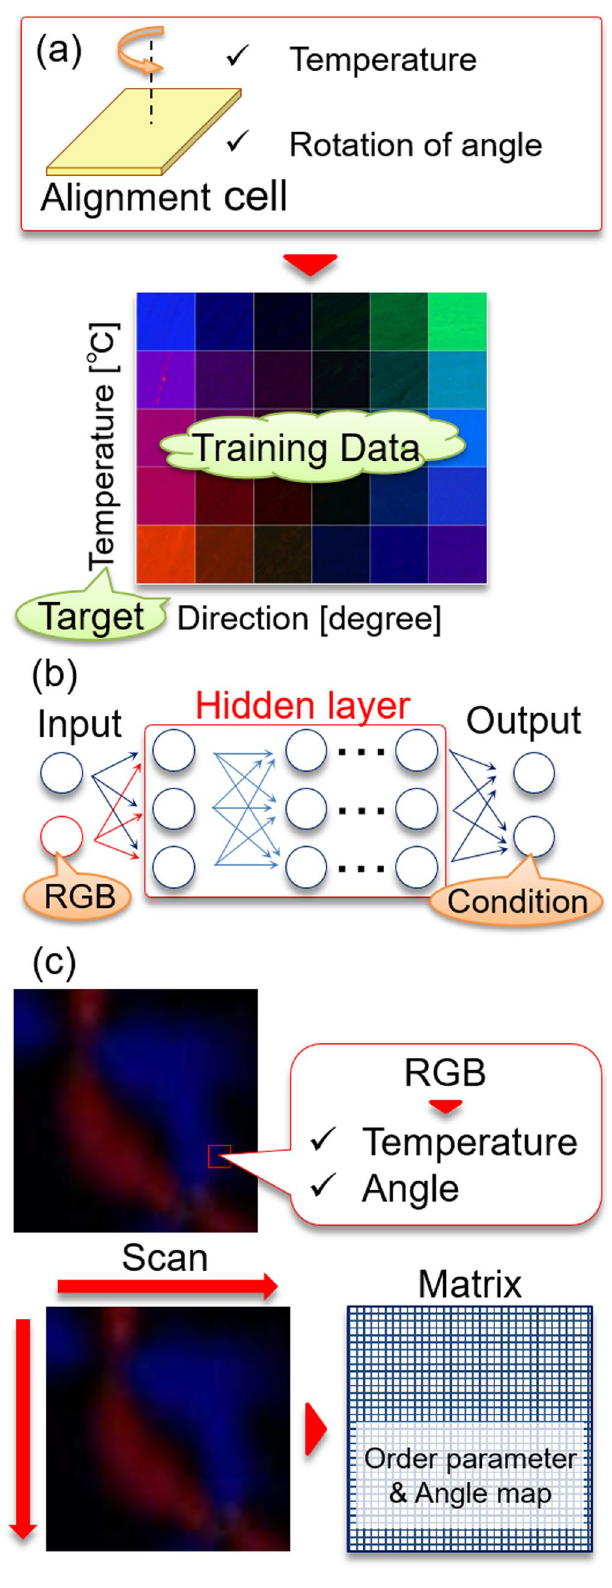
Figure 1. The summary of the methodology of predicting the orientation angle and the temperature by using the neural network function is shown. (a) The color information for different angles and temperatures in a planer alignment cell was collected. (b) The neural network function was trained by the RGB data to provide the orientation angle and temperature. (c) At each local position, the color information is converted into the temperature and angle. This calculation was performed for all the pixels of images by scanning, and the data was changed into the order parameter and angle map (prepared by PowerPoint